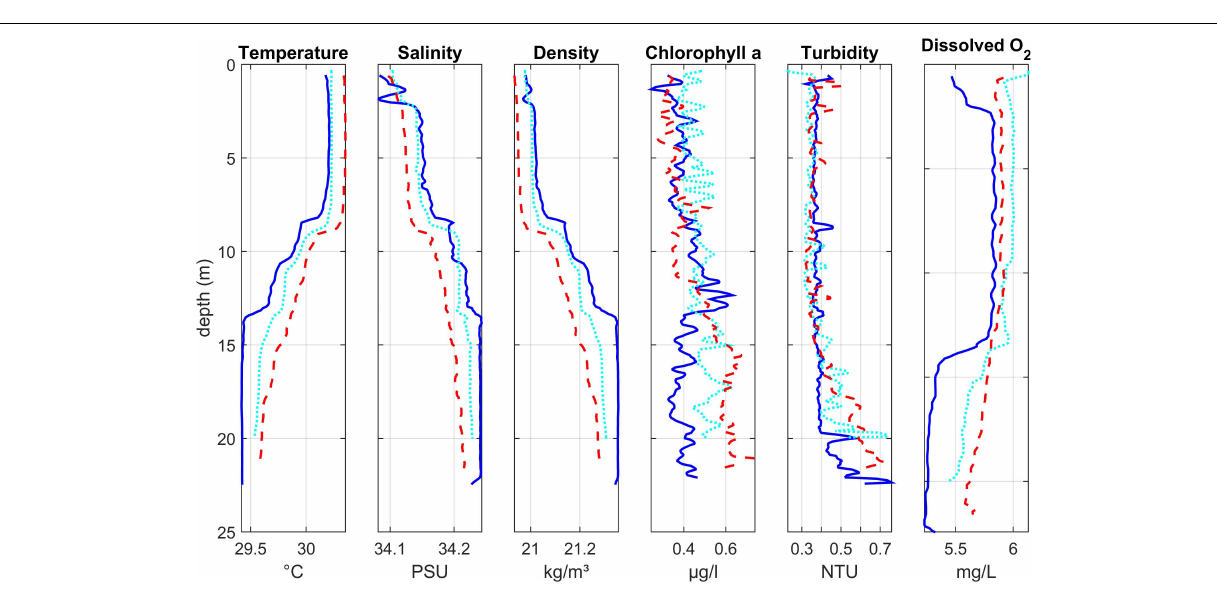
at Ocean_02, and 10 at Ocean_03 ( Figure 6 ).